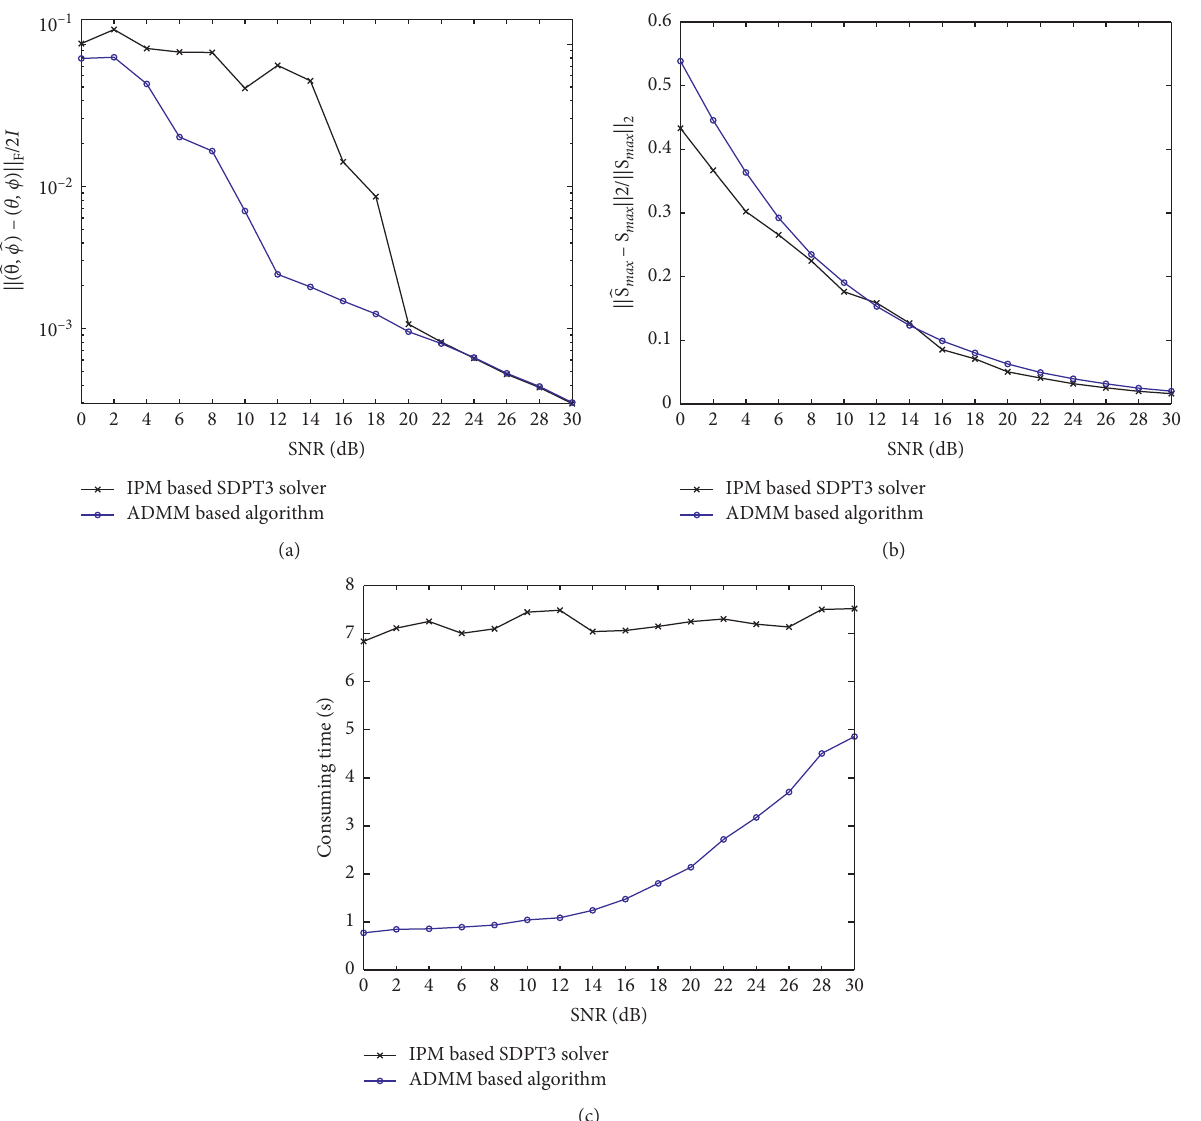
Figure 3: Curves of (a) ‖[ 􏽢 θ , 􏽢 ϕ ] − [ θ , ϕ ]‖ microphones is employed.